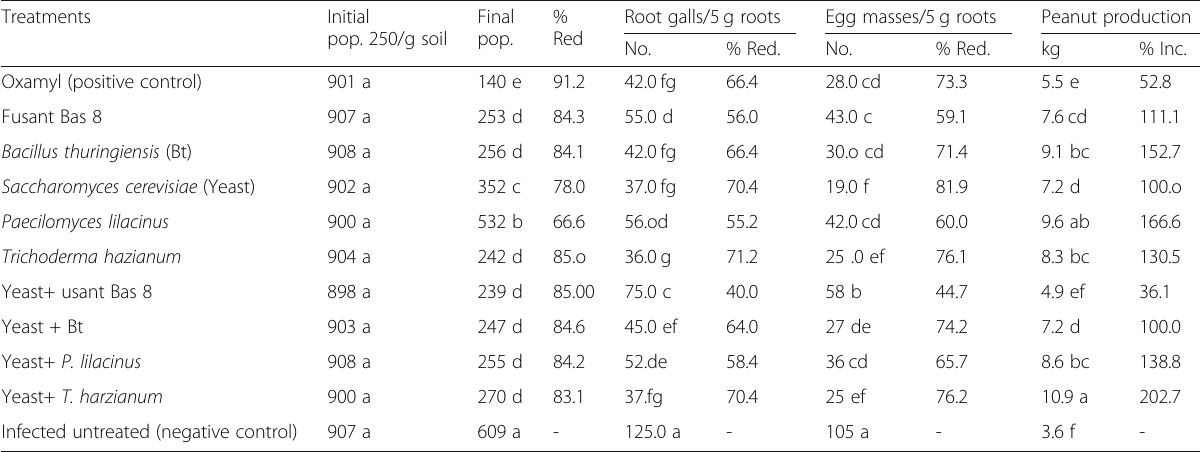
Table 3 Effects of fusant Bas 8, Bacillus thuringiensis , Saccharomyces cerevisiae , Paecilomyces lilacinus , Trichoderma harzianum , and oxamyl on peanut plants cv. Giza 6 infected with root-knot nematode Meloidogyne javanica under field conditions Treatments